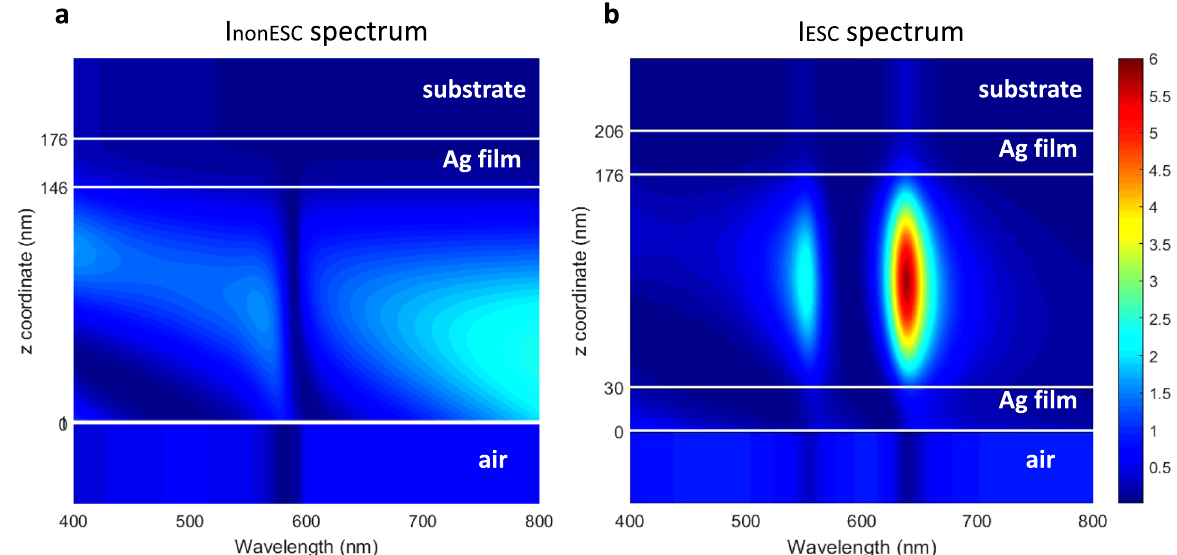
Fig. 6 Electric fi eld intensity of the samples. a,b Electric fi eld intensity spectra of molecules outside ( a ) and inside ( b ) the FP cavities along z